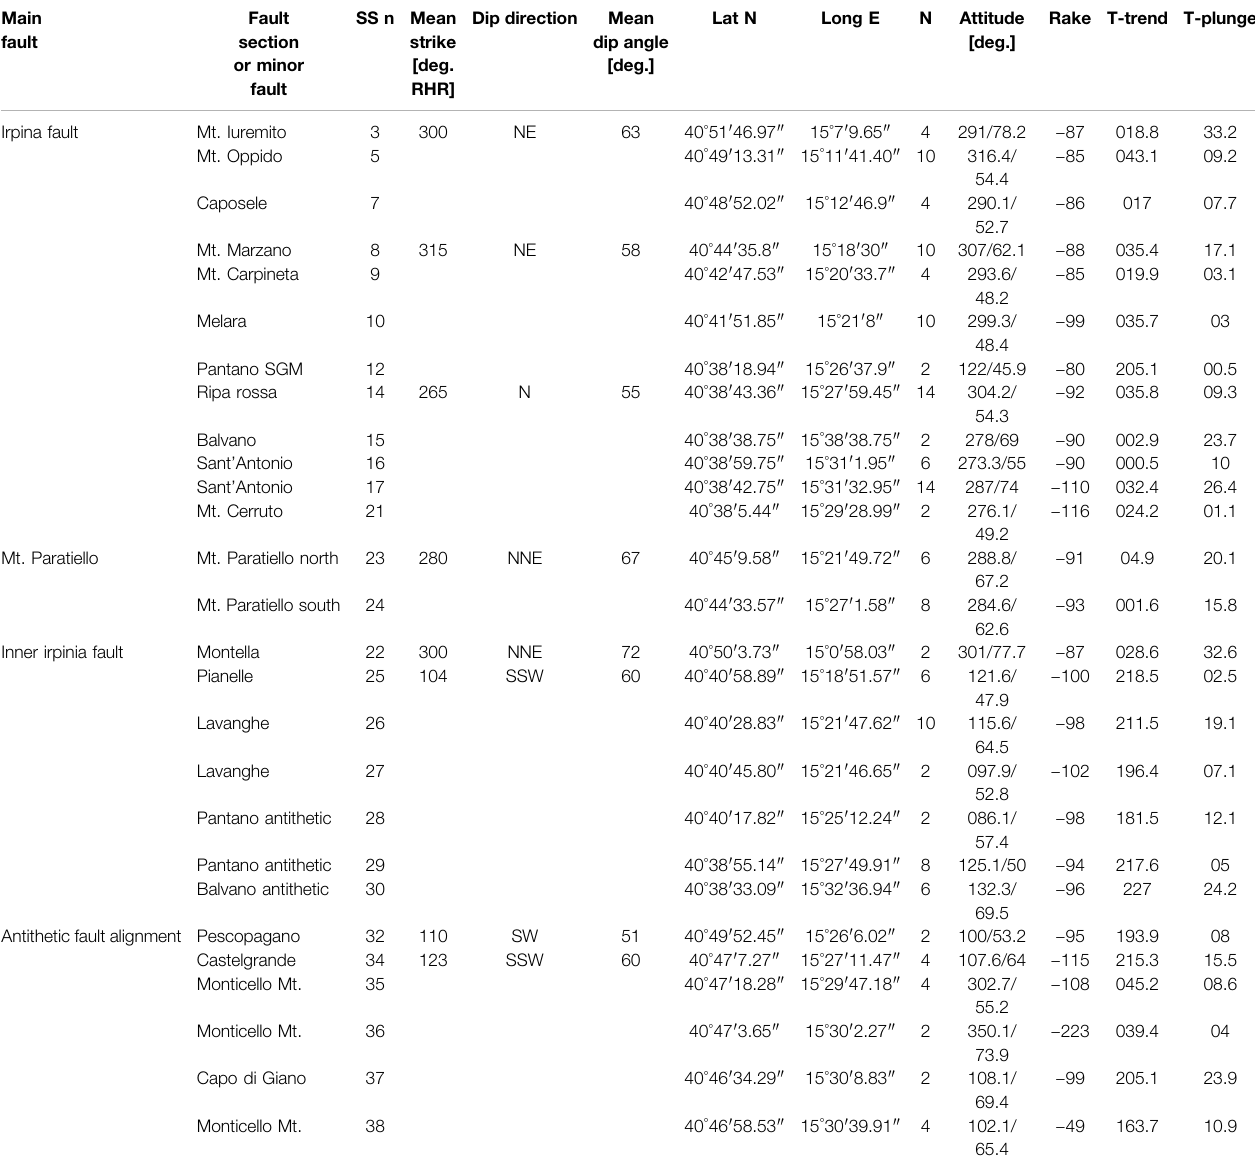
TABLE1| Pseudo-focalmechanismsparameters.LatNandLongEarerepresentativelocationastheyrefertoanaveragelocationofanumberofneighboringdatapointsat different outcrop sites; N (cid:1) number offault slip/dataused for thepseudo focalmechanismcomputation. Attitude isin strike/dip and rake isinAki-Richards format; Taxis (trend/plunge) have been computed applying the dihedron angle method to fault populations (Angelier and Mechler, 1977). Main